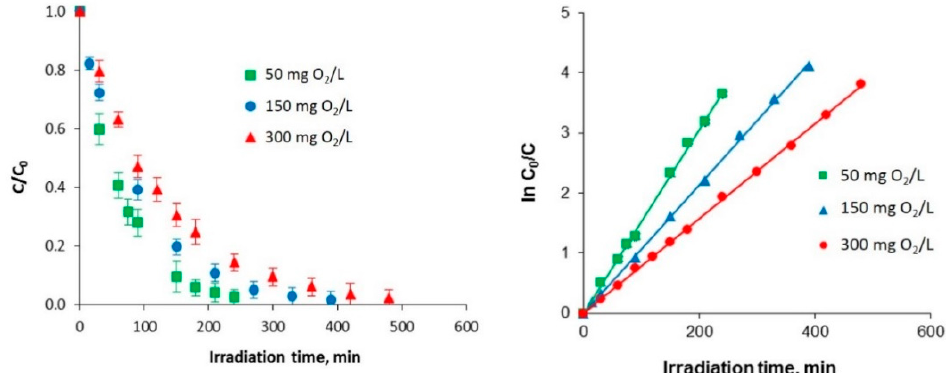
Figure 2. Kinetics of 2,4-dichlorophenol photocatalytic degradation as a function of its initial concentration. Error bars represent the calculated standard deviation for the experimental data.